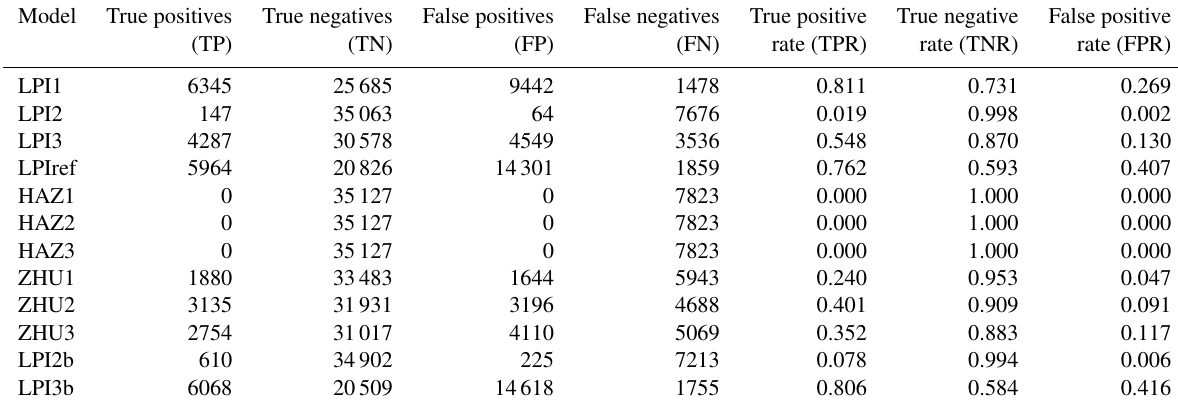
Table 5. Summary of contingency table data and diagnostic scores for all models using initial threshold estimates, including “LPI” models subject to sensitivity test without Juang et al. (2005) correction factors being applied to the factor of safety. Refer to Table 4 for descriptions corresponding to model